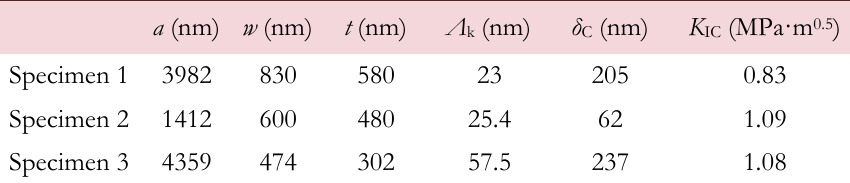
Table 1: Pre-crack length a and width w ; Thickness of the thinned region t ; Synthesis of the results: length of singular stress field Λ k and critical crack opening displacement δ C